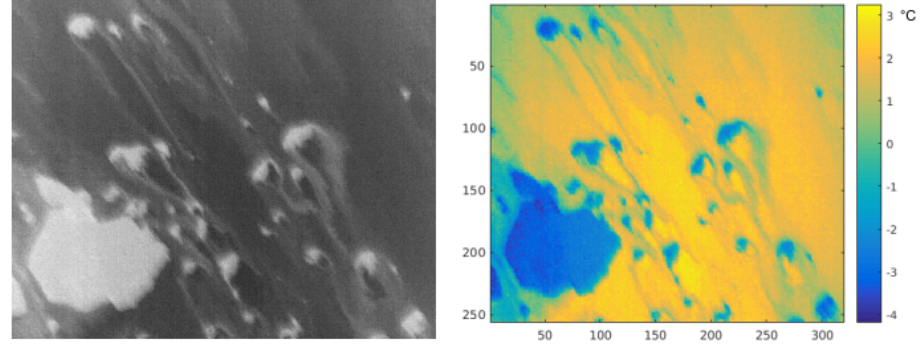
Figure 19. Thermal image obtained with FLIR A35 camera mounted on OTTO UAV (greyscale on the ( left ), false colours on the ( right )).